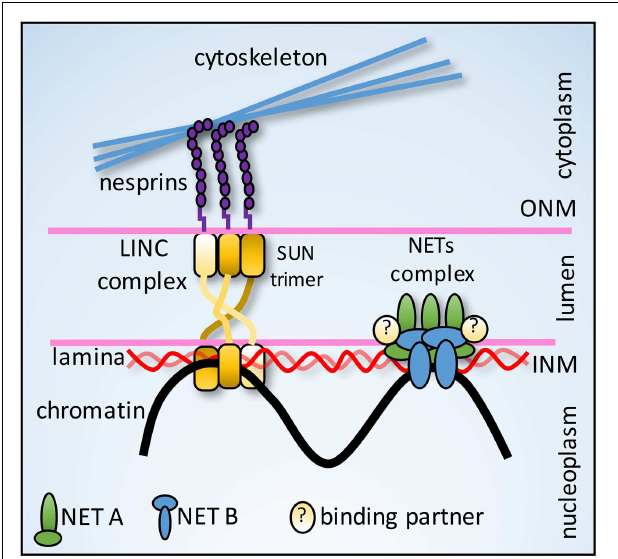
FIGURE 4 | Nut-and-bolt model for anchoring tethers. Nesprins (KASH-domain NETs) in the ONM connect in the lumen just under the membrane to SUN protein NETs in a trimeric interface stabilized by a triple helix formed by the three SUN protein molecules. This fanning out under the membrane could better distribute forces to withstand pulling forces from cytoplasmic filaments. NE-genome anchoring tethers could similarly utilize interactions with other NETs and luminal proteins to distribute chromosomal forces and prevent the NETs from being pulled from the